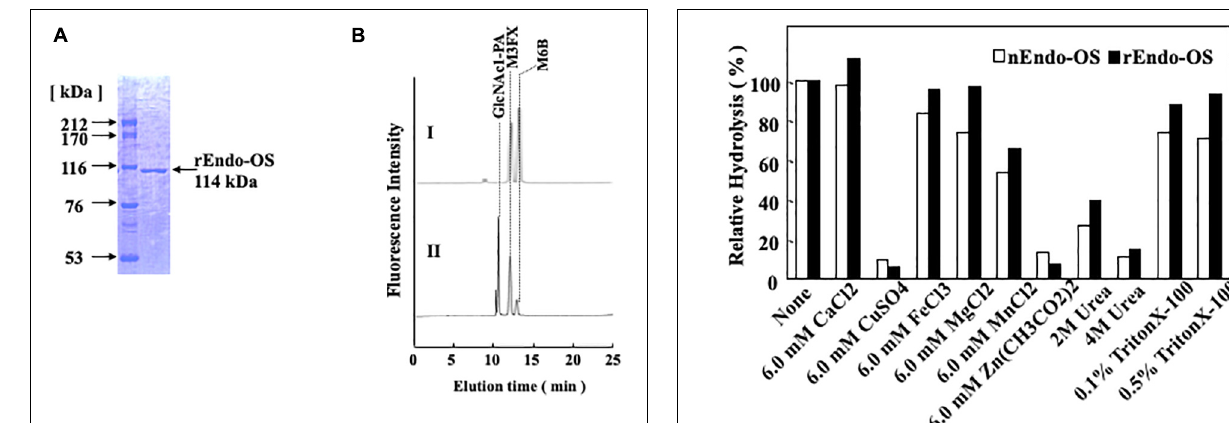
Frontiers in Plant Science |